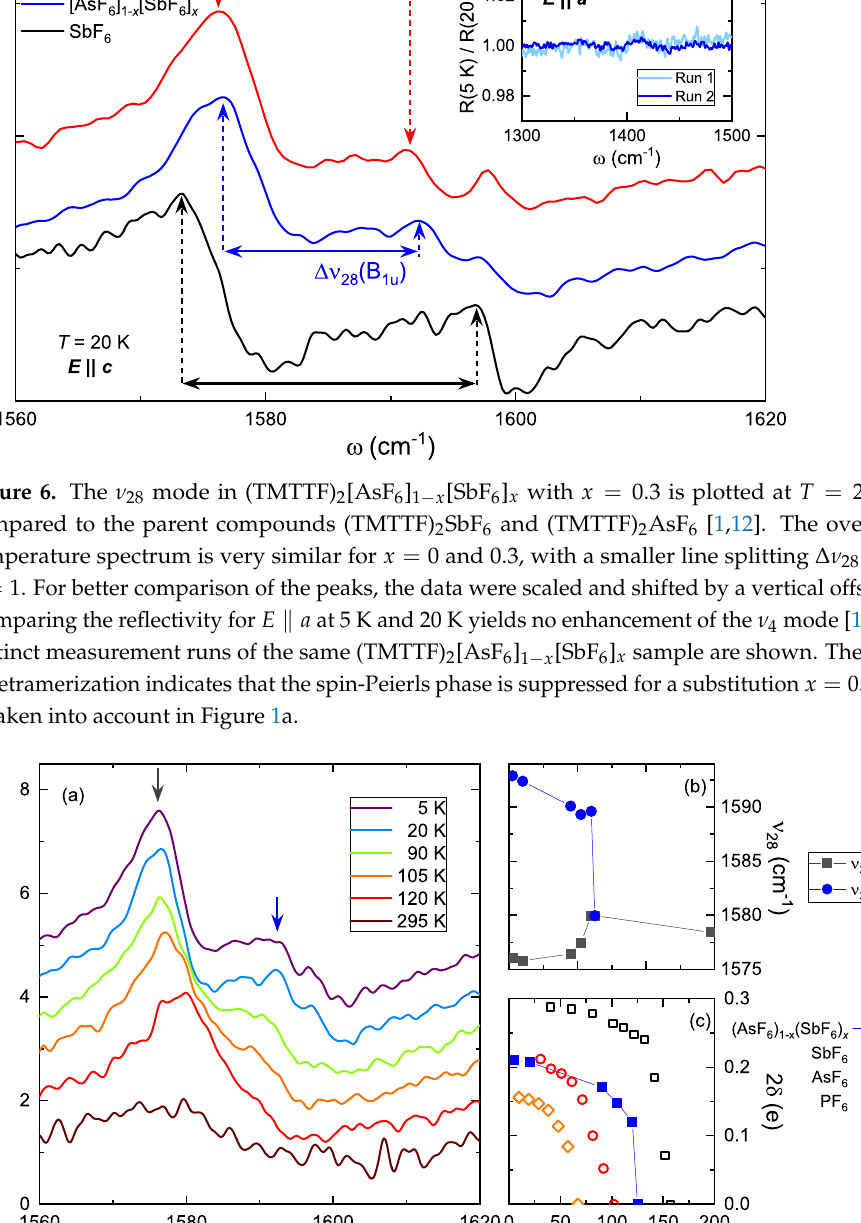
, AsF − and SbF − (data taken 6 6 6